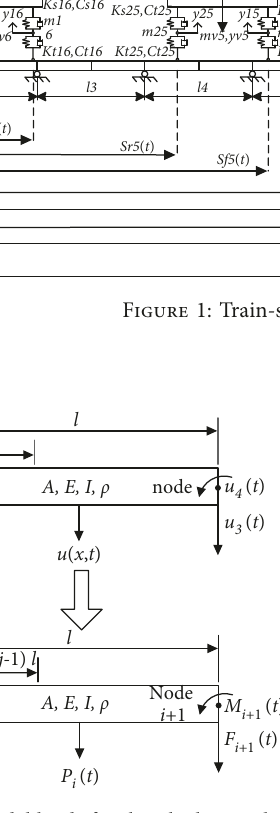
Figure 2: Equivalent nodal loads for the j th element loaded by the train-structure interaction